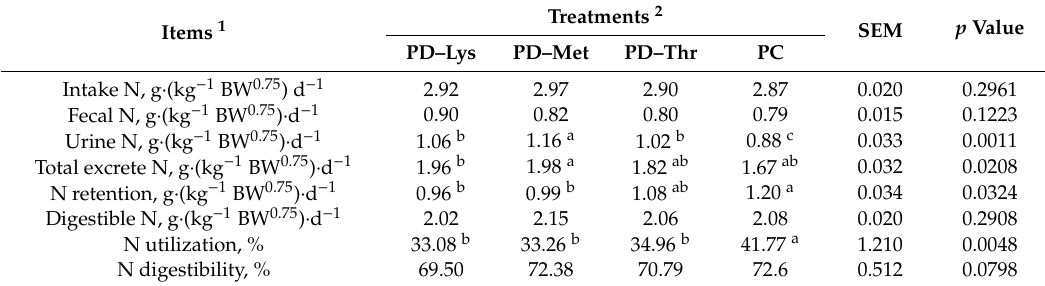
Table 4. E ff ects of deleting Lysine, Methionine, and Threonine levels in corn–soybean based TMRs on nitrogen metabolism of heifers aged seven to nine months old (n = 16).